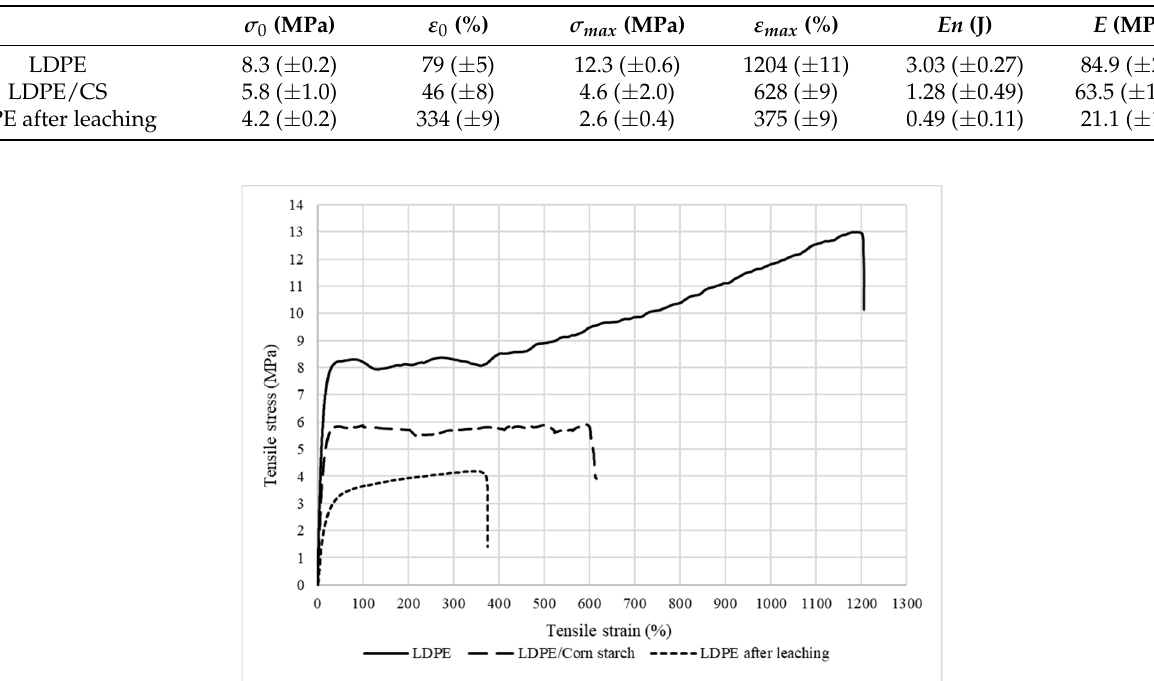
Table 4. Mechanical properties in tension: tensile stress at yield ( σ 0 ), strain at yield ( ε 0 ), tensile stress at break ( σ max ), strain at break ( ε max ), energy at break ( En ), and Young’s modulus ( E ).